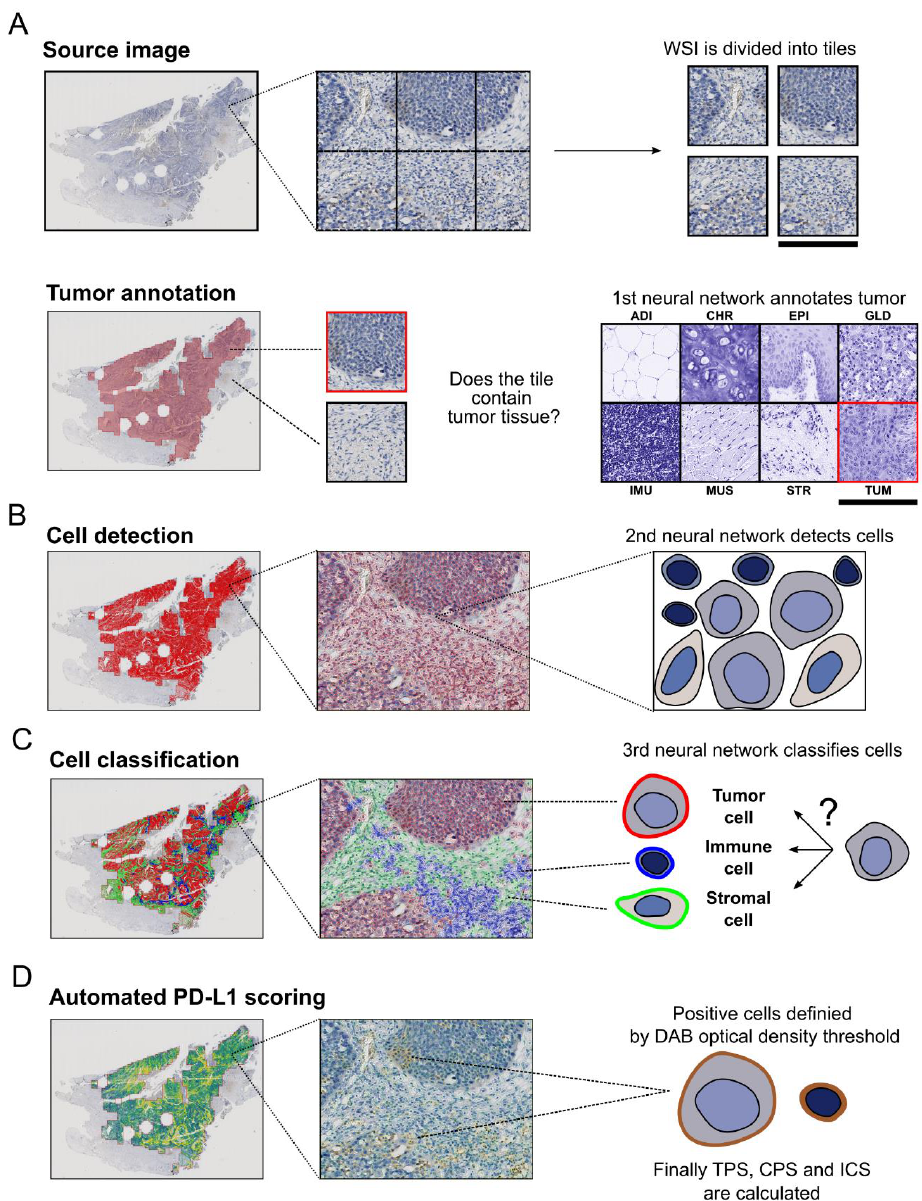
Figure 1. Method for the automated determination of PD-L1 scores. ( A – D ) A Whole slide image (WSI) from routine diagnostics. Note that the holes in the tissue correspond to sampling sites of previously made TMAs; ( A ) Step 1: The whole slide image (WSI) is first divided into separate tiled images. Then, using the first neural network (CNN “ shufflenet ” ), each tile image is classified into one of eight tissue classes (ADI, adipose tissue; CHR, cartilage tissue; EPI, epithelium; GLD, glandular tissue; IMU, immune cells; MUS, muscle tissue; STR, stromal tissue; TUM, tumor tissue) in a sliding window manner. The regions of WSI whose tile images were classified as tumor are annotated. Scale bar equals 256 µm. ( B ) Step 2: In the annotated tumor region, the cells are detected and quantified (cell/nucleus size and shape, strength of hematoxylin staining and DAB staining, etc.) by the second neural network (CNN “ StarDist ” ); ( C ) Step 3: All recognized cells are classified by the third neural network (ANN-MLP) into tumor, immune or stromal cells based on their characteristics; ( D ) Step 4: Positive tumor (based on the membrane) and immune cells (based on the whole cell) are detected using a DAB optical density threshold. Thereby, the TPS, CPS and ICS can be finally calculated.